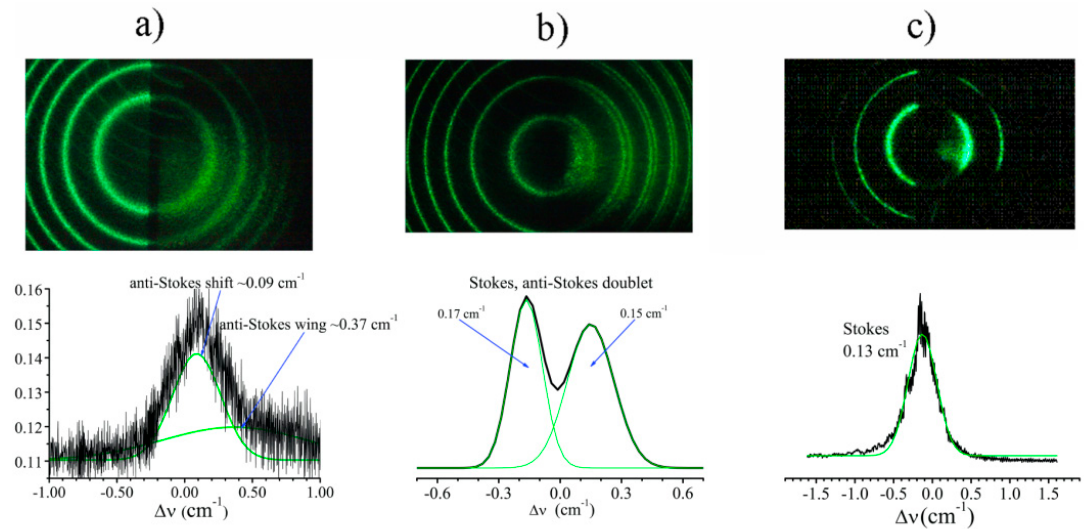
Figure 8. SRMS backscattering light spectra initiated by 100 picoseconds pulses in Ag nanoparticle colloids in toluene ( a ) and ZnO nanoparticle colloids in water ( b , c ). The results are given for the following experimental schemes: ( a ) four-wave mixing scheme at the mild focusing case (Figure 4b with F 2 = 21.5 cm): ( b ) sharp focusing scheme (Figure 4a with F 0 = 5 cm); ( c ) scheme of Figure 4a with the replaced lens of F 0 = 15 cm focal length.